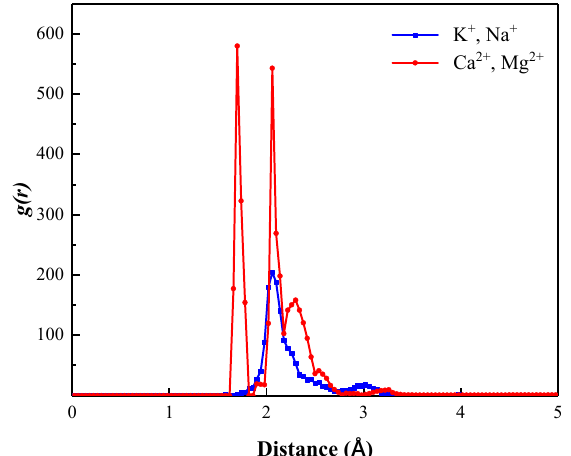
Figure 10. Radial distribution function of OH − with monovalent and divalent cations in “SDBS/HPAM/OH − ” system.